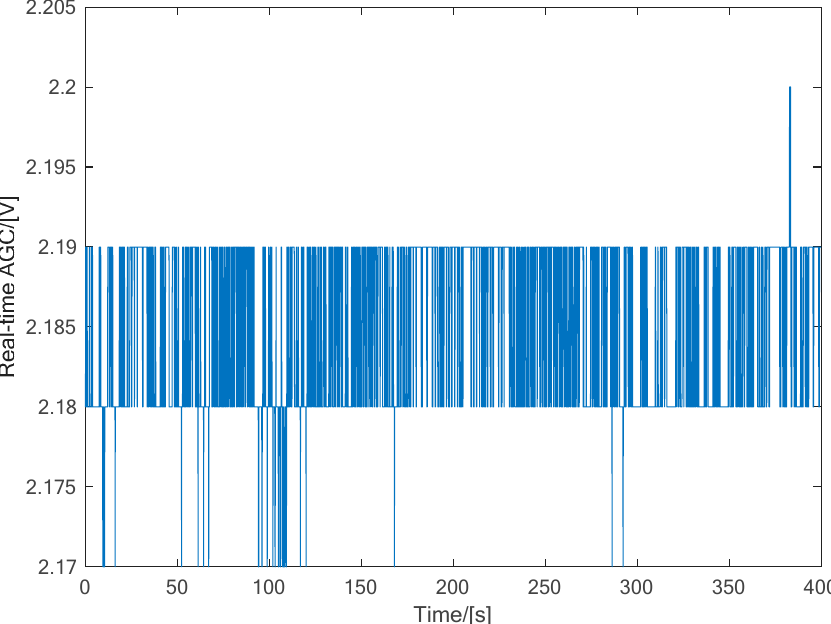
Figure 16. Real-time AGC of SOTM of the method in this paper.